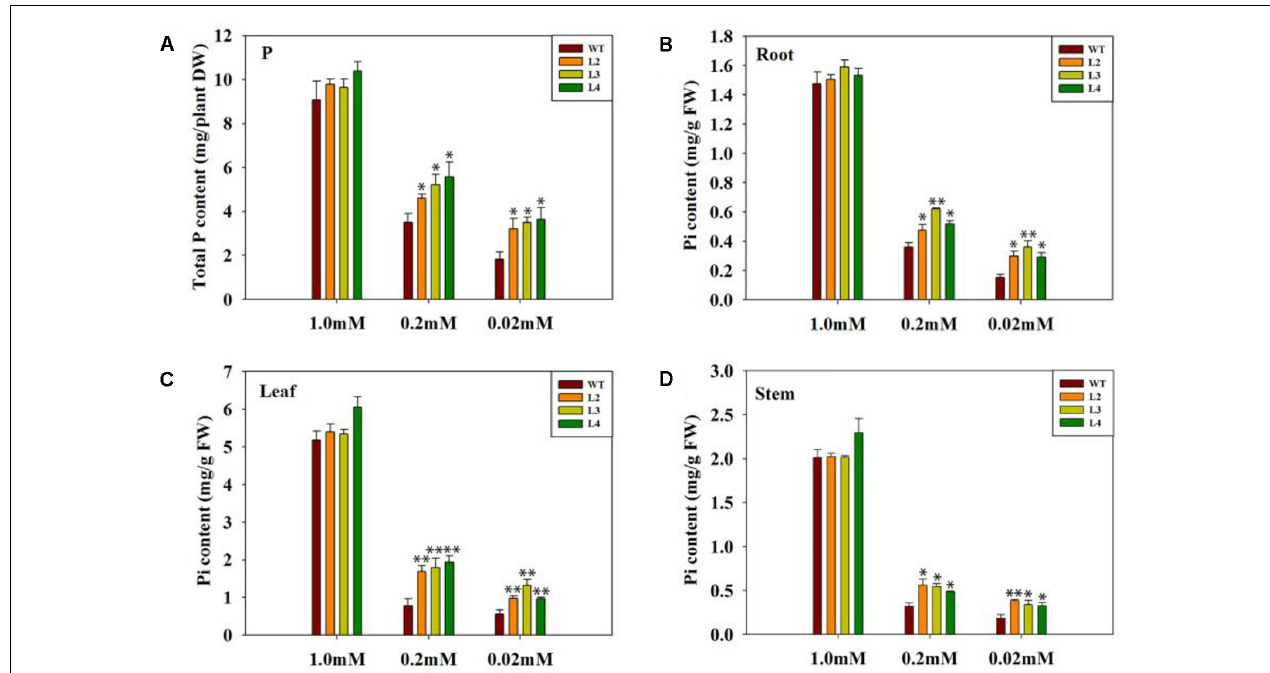
FIGURE 5 | Comparison of total P and Pi content between WT and transgenic plants. Plants were grown under variable Pi conditions for 15 days. (A) Total phosphorus content of WT and transgenic lines under different Pi concentrations. Seedlings (after germination) were treated with 1.0 mM phosphorus (CK), 0.2 mM phosphorus, and 0.02 mM phosphorus (LP) for 15 days under sand-culture system. Seedlings were subsequently harvested for measuring phosphorus content. Values are means ± SD. n = 4 for each genotype. (B–D) The Pi content of the leaves, stem and root under normal Pi and low Pi conditions. Pi content was measured in harvested 15-day-old tomato plants. Values represent the means ± SD of three replicates. Asterisks indicate significant differences compared with WT plants (Student’s t -test). DW, dry weight; FW, fresh weight; ∗ P < 0.05; ∗∗ P < 0.01.